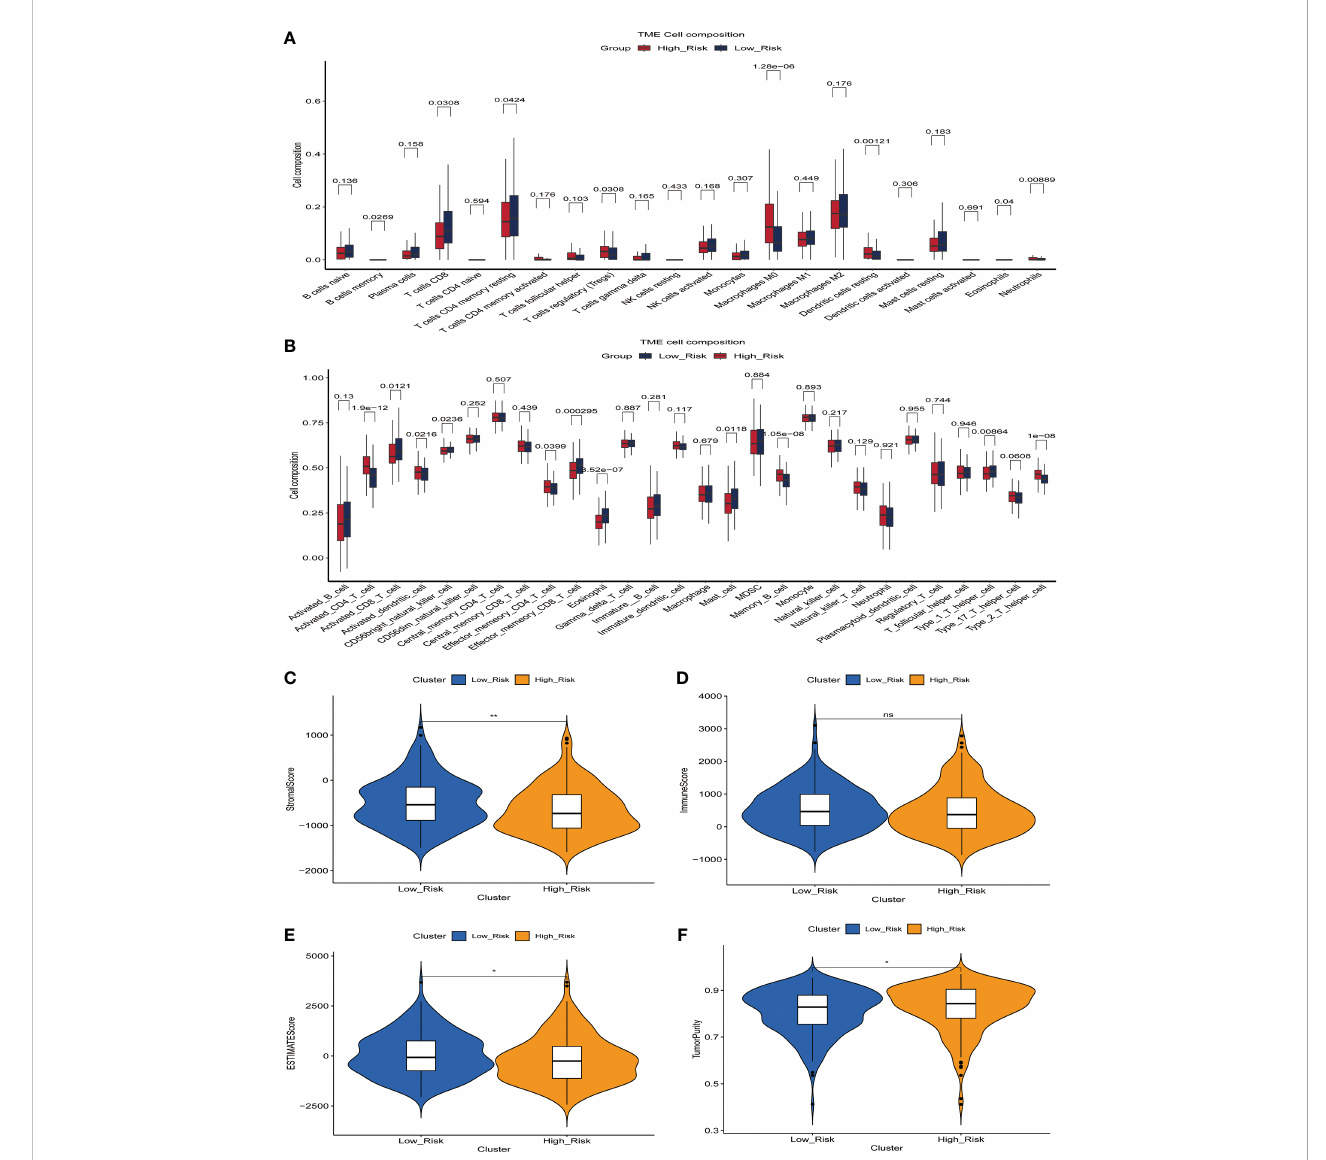
FIGURE 5 The relationship between prognostic signature and the proportion of immune cell in fi ltration in the tumor microenvironment. (A) Differences in the proportion of in fi ltrating immune cells between the high-risk and low-risk groups. (B) Differences in the proportion of 28 immune cell in fi ltrates in the tumor microenvironment between high- and low-risk groups. (C-F) Relationship between prognostic signature and StromalScore (C) , ImmuneScore (D) , ESTIMATEScore (E) and TumorPurity (F) in the training